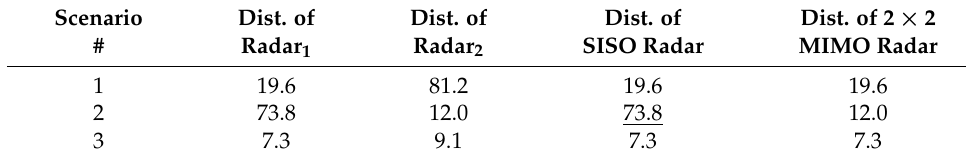
Table 3. The DTW distance metric for the SISO and 2 × 2 MIMO radar systems. Scenario Dist. of Dist. of Dist. of Dist. of 2 × 2 Radar 1 Radar 2 SISO